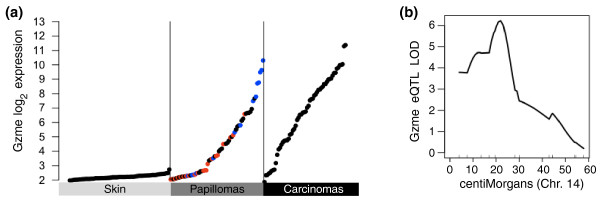
Granzyme E alleles are associated with su sceptibility. (a) Log2 expression of Gzme in skin, papillomas, and carcinomas. Gzme mRNA is not detected in normal skin, and its level of expression is highest in papillomas from mice that are relatively resistant to papilloma development. Papillomas from resistant animals are plotted as blue circles, susceptible animals as red circles. (b) Expression of Gzme in papillomas and carcinomas is under germline genetic control. LOD plot for Gzme carcinoma eQTL significance on chromosome 14.